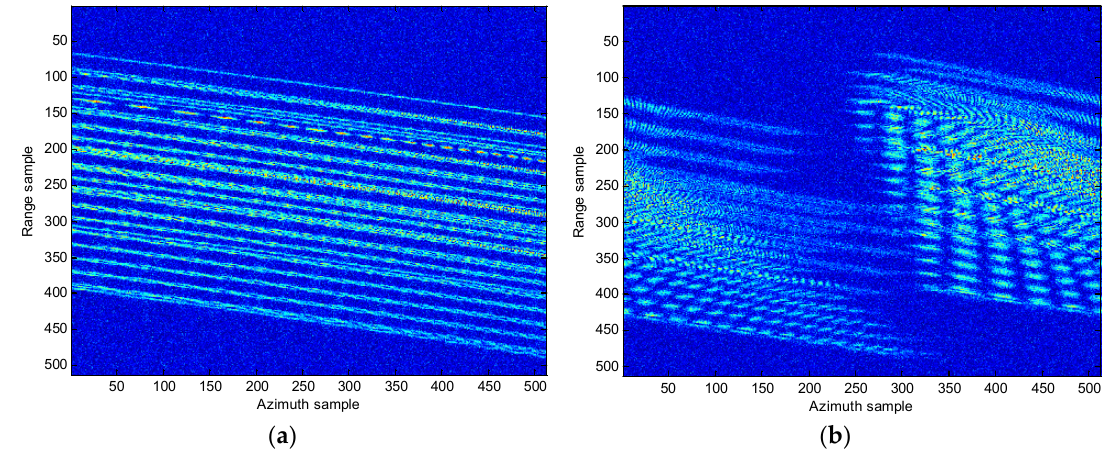
Figure 8. Range compression and imaging result without migration compensation. ( a ) Range compression; ( b ) RD imaging result.